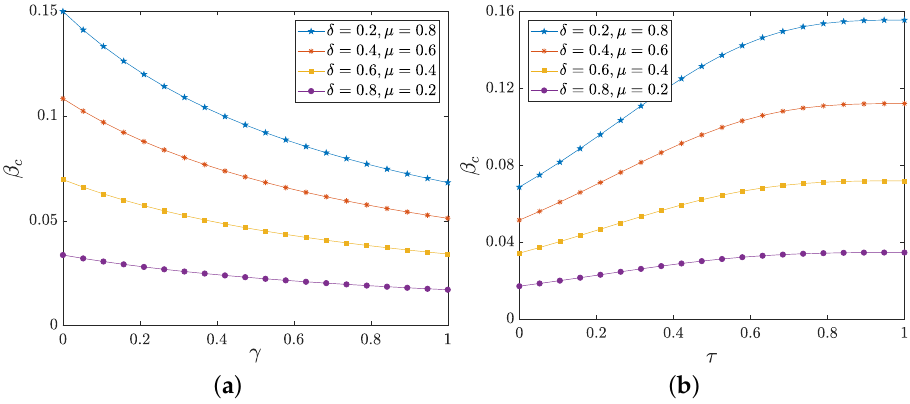
Figure 6. ( a ) The outbreak threshold β c as a function of the attenuation factor γ . ( b ) β c as a function of the inter-layer feedback parameter τ . The result of ( a ) is obtained for τ = 0.5 and that of ( b ) is for γ = 0.1. Other parameters are fixed as λ 1 = 0.9, λ 2 = 0.5, ι = 1.1, ¯ x = ¯ y = 3.